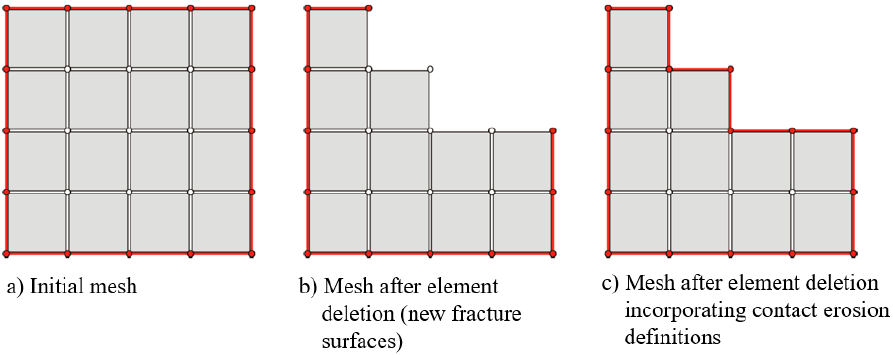
Figure 9. Effects of element deletion on the contact area (red line) of a mesh.